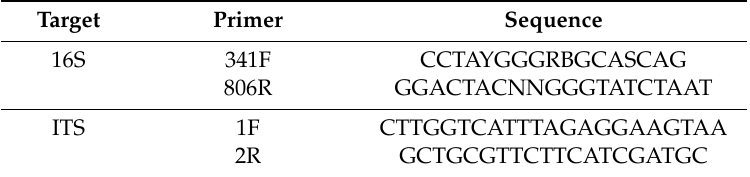
Table 1. Forward and reverse primers used to target 16S and ITS regions